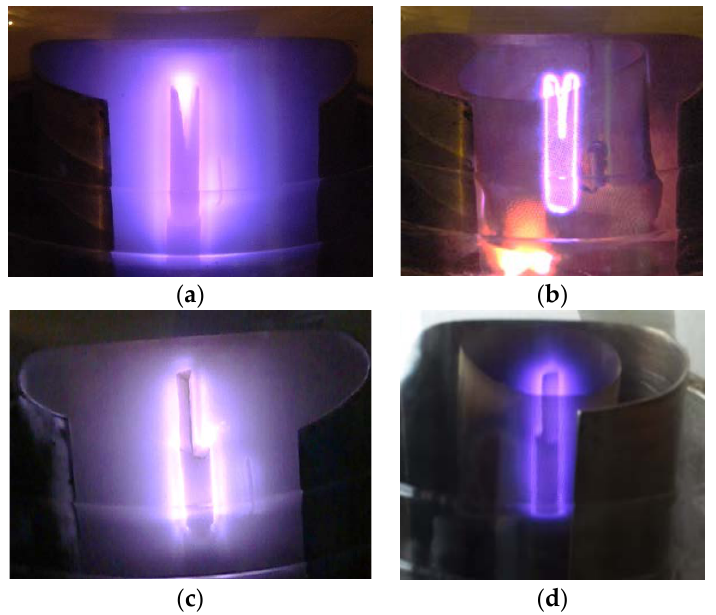
Figure 3. Images of the nitriding enclosure. Sample with interior angles: ( a ) no screen nitriding, and ( b ) active screen nitriding. Sample with exterior angles: ( c ) no screen nitriding and ( d ) active screen nitriding.